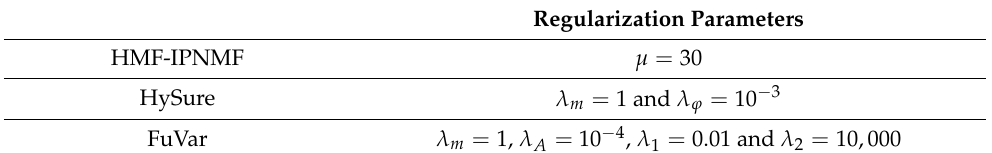
Table 3. Regularization parameters for the HMF-IPNMF, HySure and FuVar methods.